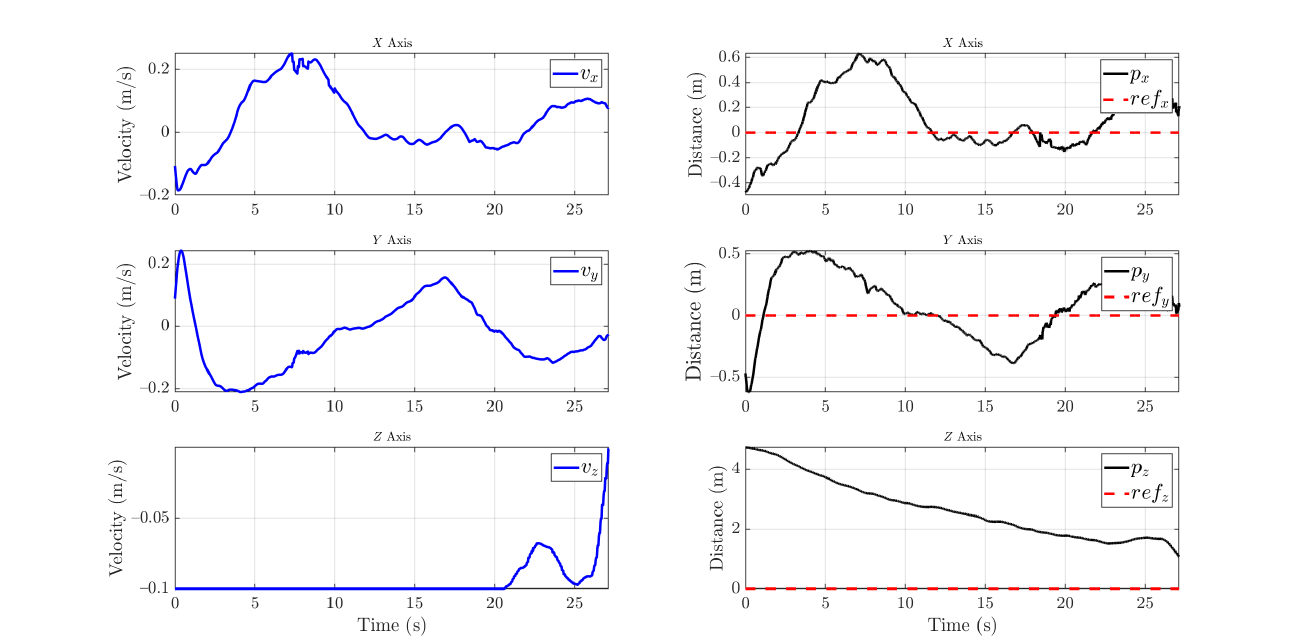
Figure 17. Control signals sent to the autopilot during landing ( blue line ) and charging pad position ( black line ) with the reference ( dotted red line ). The UAV aligns with the platform in the horizontal plane while descending at a constant speed. The second phase of detection begins at 1.8 m, slowing the descent speed and waiting for the optimum horizontal plane alignment to achieve a safe